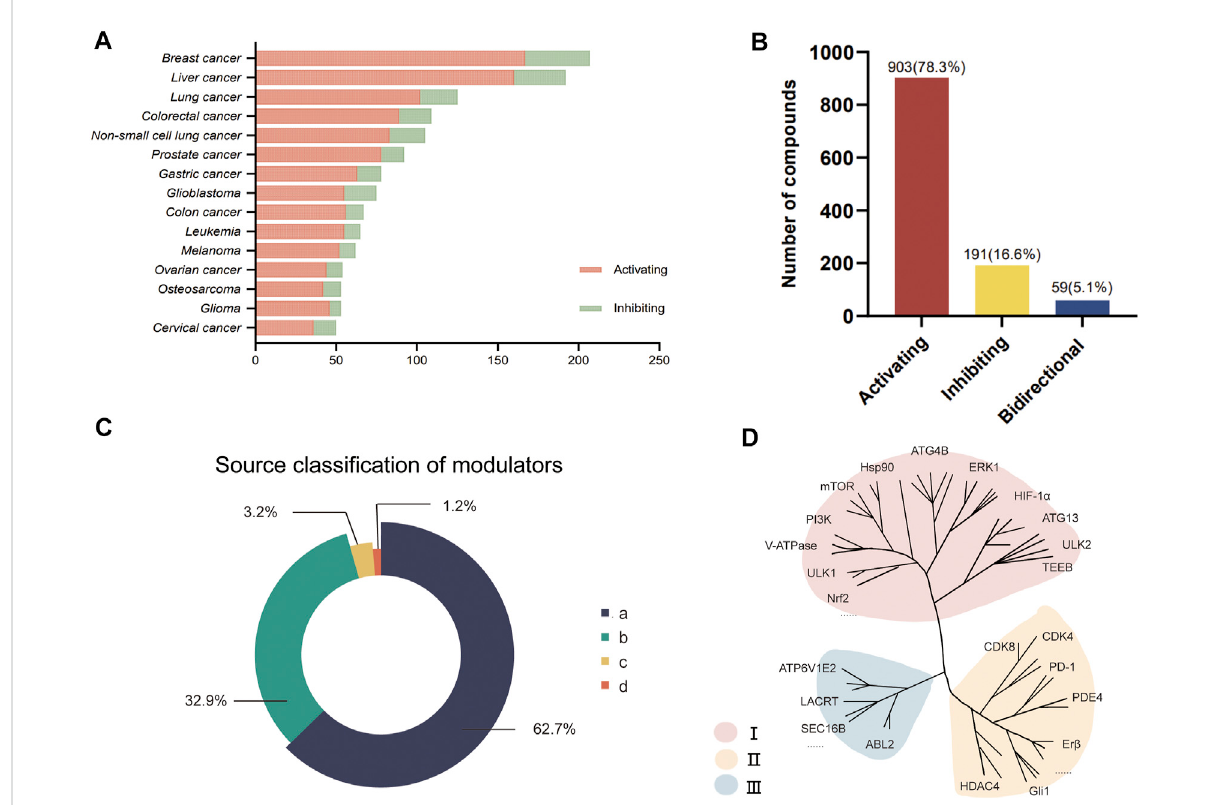
FIGURE 2 Data visualizations. (A) Stacking bars show the function of autophagy modulators in different tumors, with only the top 15 tumor types listed here; (B) Functional distributiondiagramof autophagy regulator; (C) Classi fi cation ofautophagymodulatorsinoriginattributes; (D) Data distribution of autophagy targets contained in